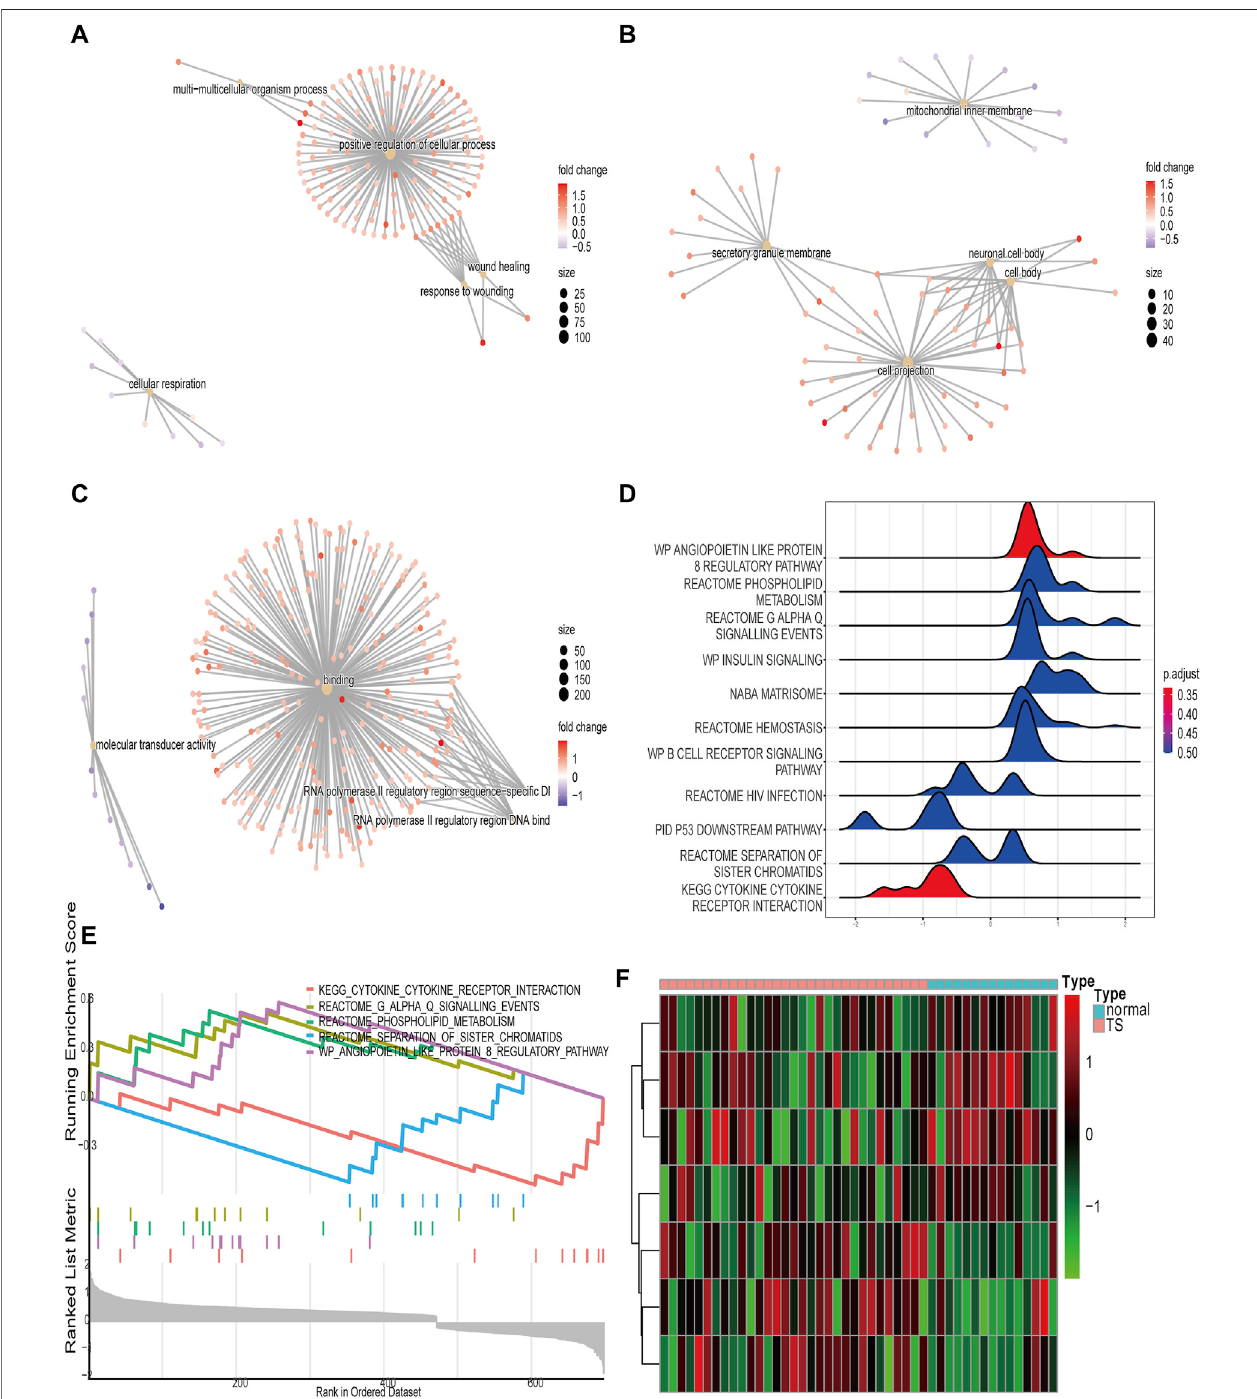
FIGURE 4 | GSEA and GSVA of the TSEs. (A – C) : The top 5 enriched GO terms of BP, MF, and CC categories are determined by GSEA. (D) : Wave plot of KEGG enrichmentobtainedby GSEA. (E) : Display ofthe fi vemost enriched pathwaysinthe GSEA ofthe KEGG database. (F) : Heat map showing theenrichmentscoresofthe hallmark ear-related TS gene